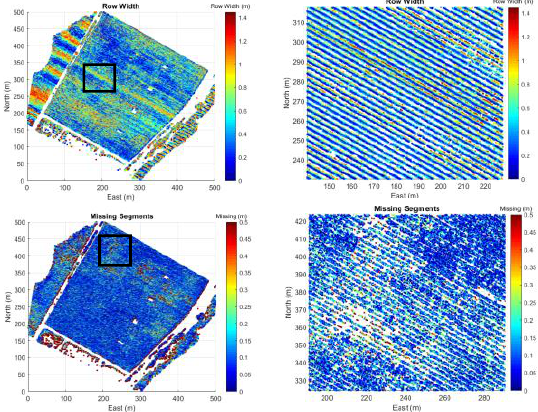
Figure 13: Spatial distribution of vine row width (top) and missing row segments (bottom) over vineyard (enlarged views on are shown on